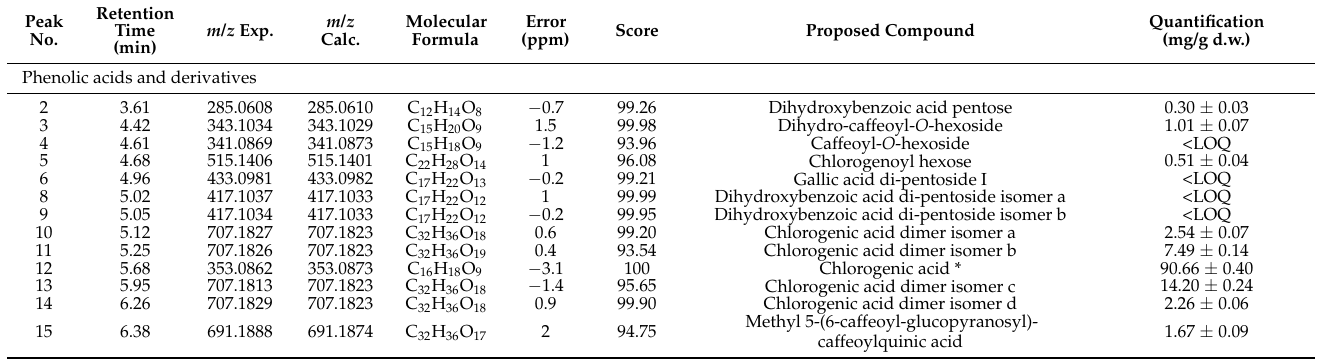
Table 4. Characterization and quantification of phenolic compounds using HPLC-ESI-TOF-MS in the optimal extract of bilberry leaves. Results of quantification are expressed as the mean ± SD ( n =